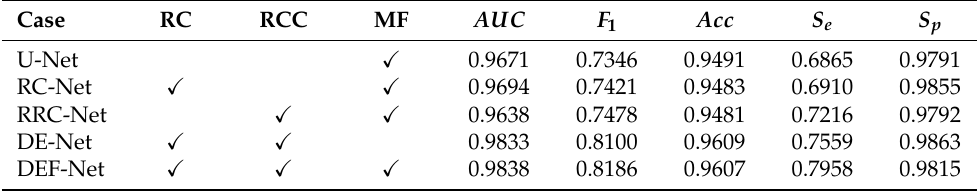
Table 3. Ablation experiment on STARE